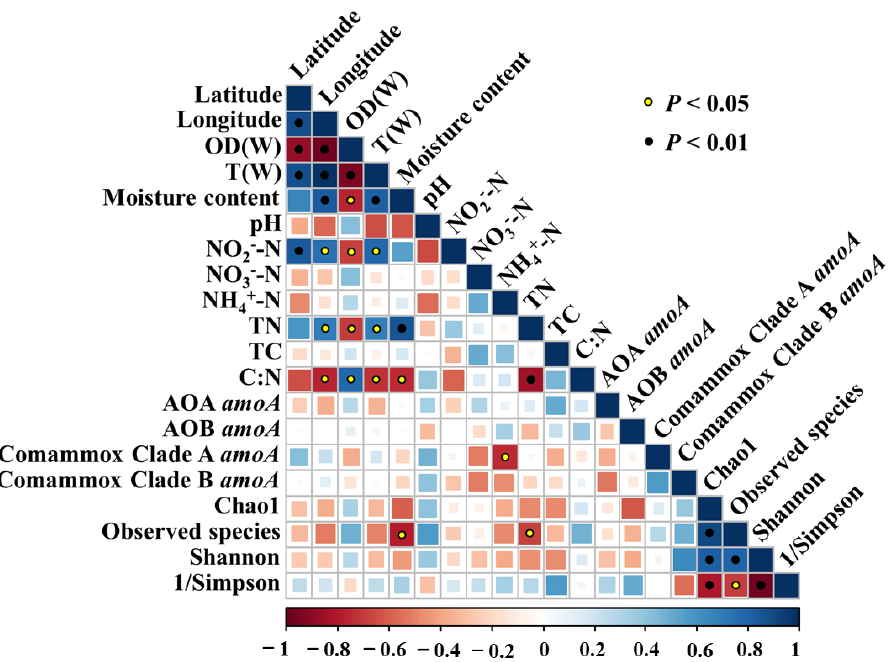
Figure 3. Heat map of correlation between AOA, AOB, comammox clade A, comammox clade B amoA , and environmental physicochemical indexes. Blue represents a positive correlation; red represents a negative correlation. Only the significant correlations are labeled in circles at the level of p < 0.05 by Duncan’s test. Scale bars indicate correlation coefficients. This figure sampled R language for analysis.